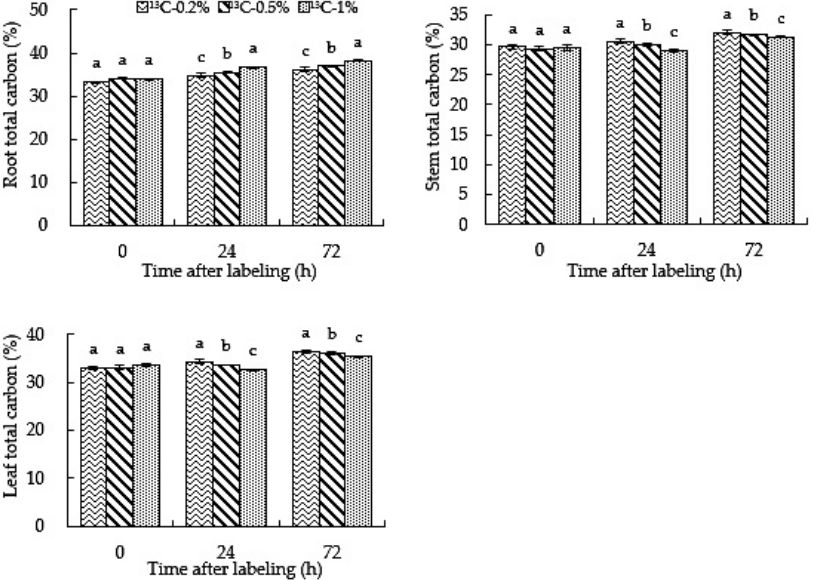
Figure 6 . High root-zone 13 CO 2 affects the total carbon content in roots, stems and leaves of oriental melon . Standard errors (SEs) of the means are represented by error bars. Different letters in the same row indicate significance at the 0.05 level among treatments.